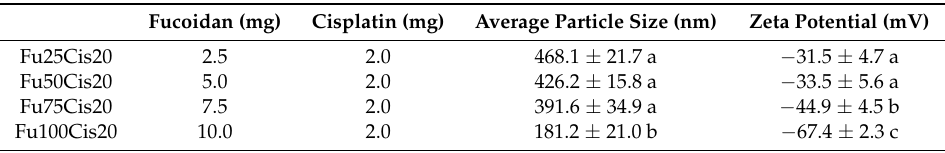
Table 3. Size and zeta potential of fucoidan-cisplatin nanoparticles by 2 mg cisplatin mixing with different weights of fucoidan. Fucoidan (mg) Cisplatin (mg) Average Particle Size (nm)